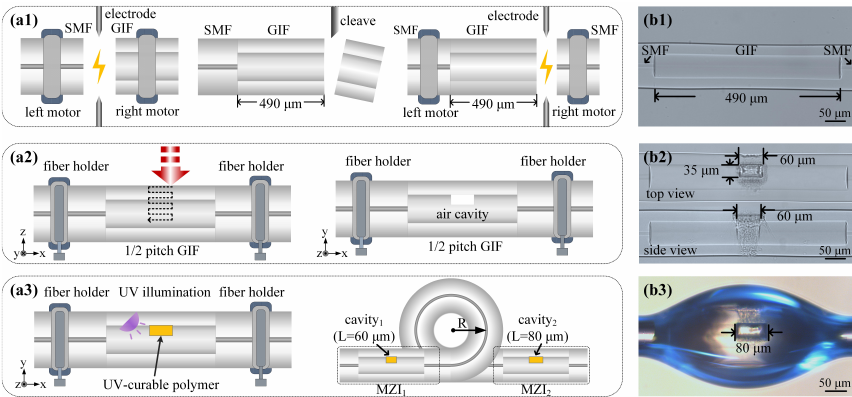
Figure 3. ( a l– a 3) Schematic diagram of the fabrication process of a cascaded polymer-infiltrated MZI temperature sensor: ( a l) in step 1, a half-pitch GIF was spliced to two sections of SMF; ( a 2) in step 2, an inner air cavity was created by femtosecond laser micromachining; ( a 3) in step 3 and step 4, the air cavity was infiltrated with UV-curable polymer and two MZI temperature sensors were cascaded.